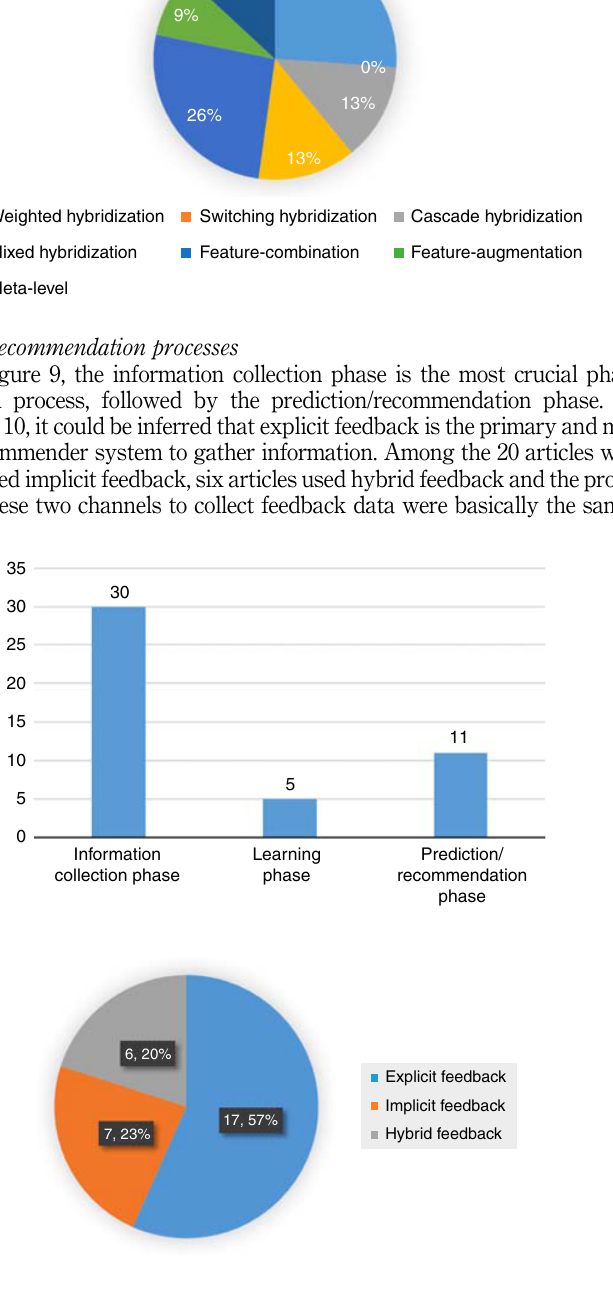
Figure 10. The distribution of